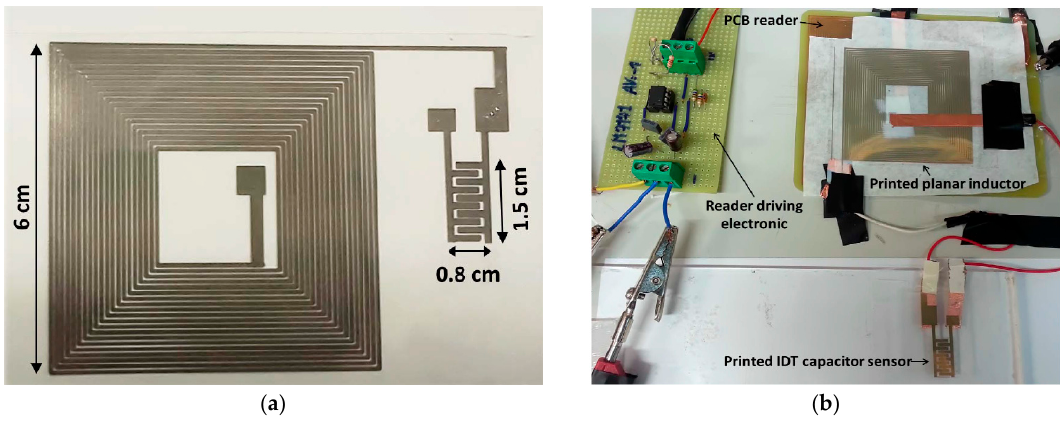
Figure 2. Inkjet-printed LC resonator on a PET substrate, serving as a touch sensor (redrawn from [38]): ( a ) layout; ( b ) complete design of the touch-sensor system (printed LC sensing block coupled to the printed circuit board (PCB)-based contactless, passive reader).